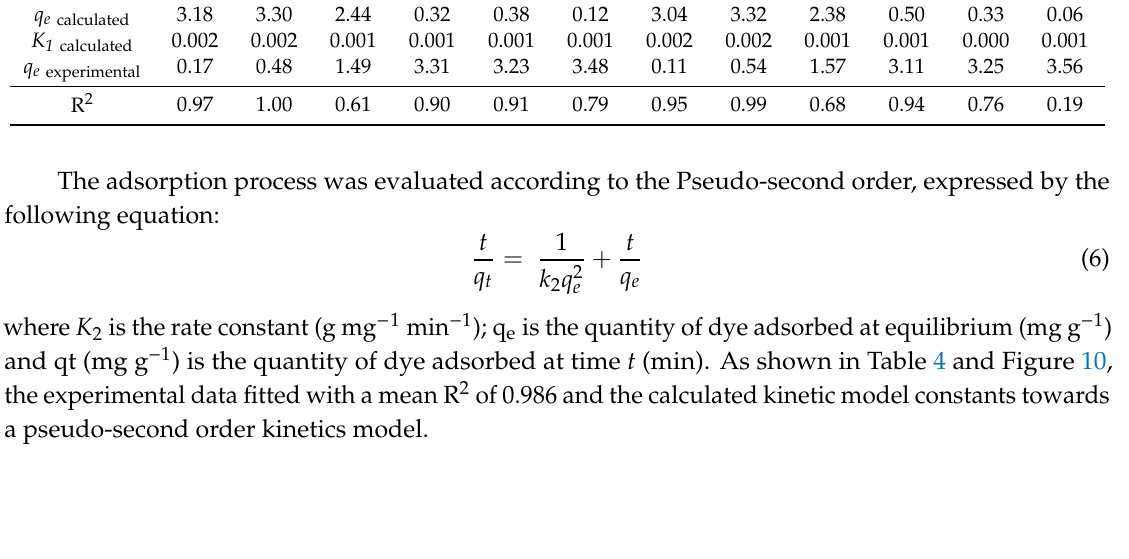
Table 1. Langmuir Isotherm data for the two types of substrates.